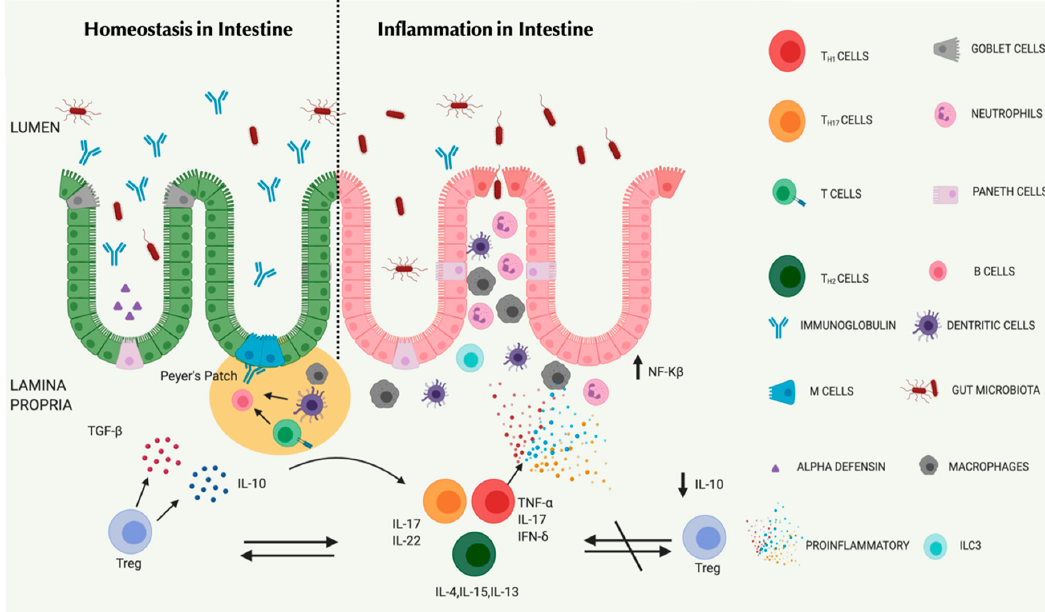
Figure 3. During the homeostasis of the intestine, the different layers of physical barriers along with chemical barriers are alerted to any presence of microbial invasion. The goblet cells release mucin 2 (MUC2), along with the activation of macrophages and dendritic cells present in the lymphoid tissues called Peyer’s patches covered by microfold (M) cells receiving antigens for testing, which triggers the release of proinflammatory cytokines. The Paneth cells also release α -defensins that are microbicidal. T regulatory (T reg ) cells release IL-10 that helps in maintaining tissue homeostasis. Innate lymphoid cells (ILC) are capable of mirroring T helper (T H ) cells, and ILC3 and T H17 cells produce